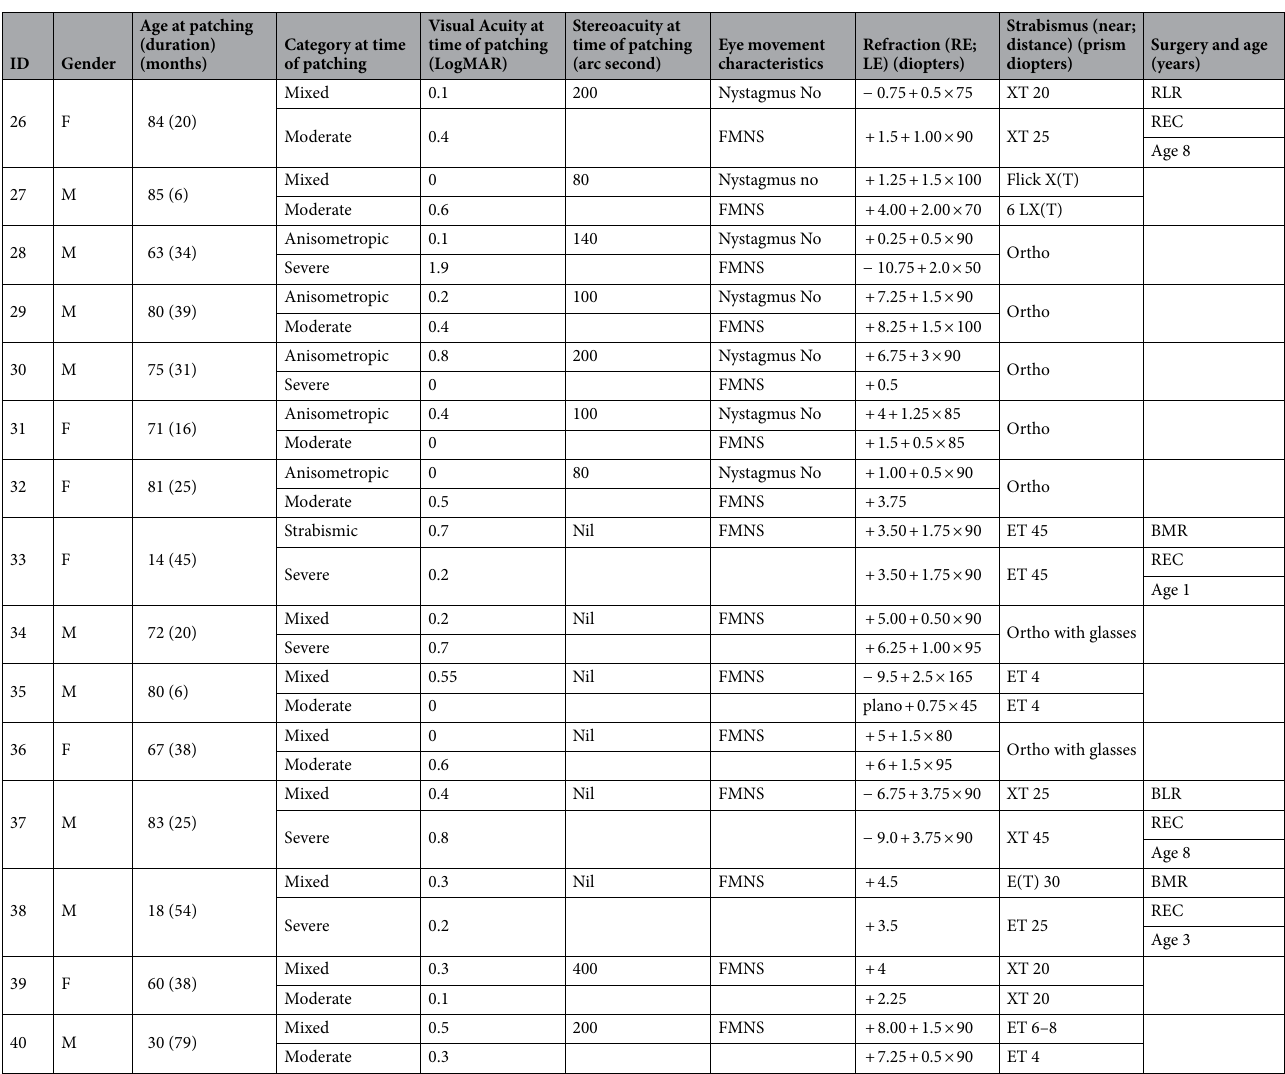
Table 1. Demographics, ophthalmic exam and strabismus surgery data of the enrolled subjects. BLR bilateral lateral recti muscles, BMR bilateral medial recti muscles, CC with correction, ET esotropia, E(T) intermittent